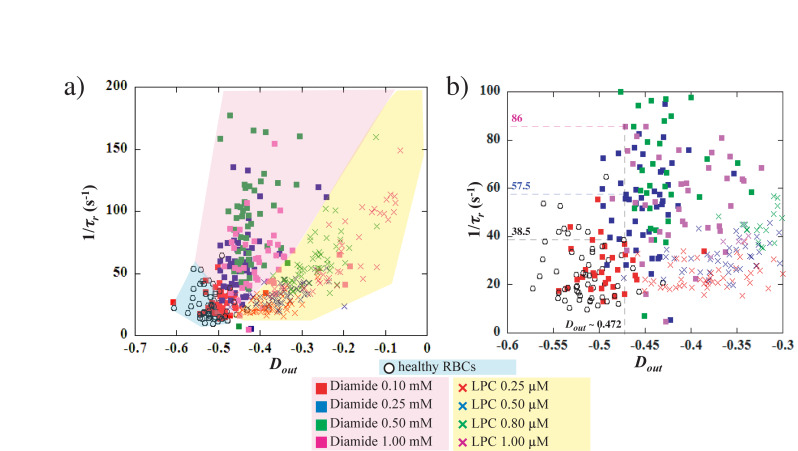
(a) evolution of 1/τr versus Dout for healthy, Diamide and LPC treated RBCs. (b) close-up of the graph in (a). For a given value of the stretching at the exit, Dout = –0.472, healthy RBC presents 1/τr = 33.5 s–1, 0.25 mM diamide treated cell has 1/τr = 57.5 s–1 and 1 mM diamide treated cell has 1/τr = 86 s–1.